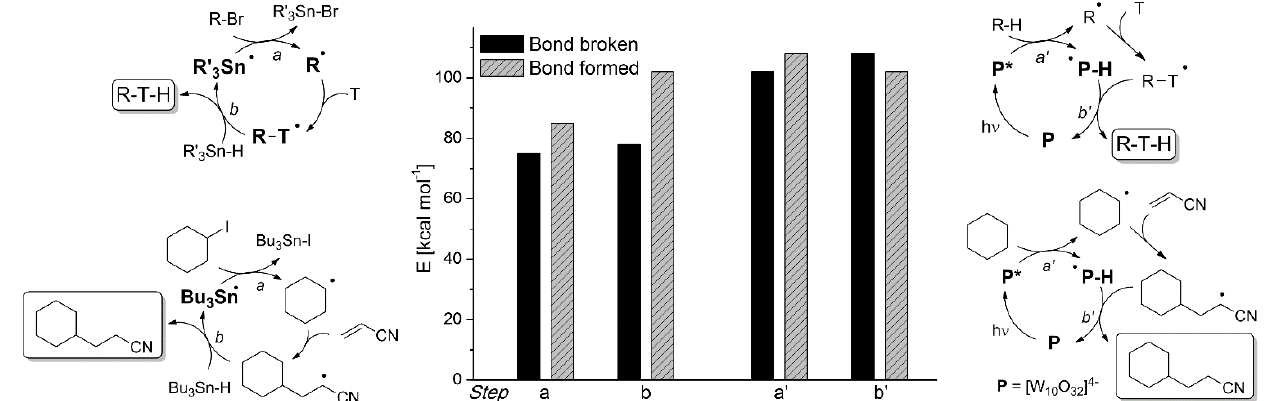
Figure 2. Chain vs. non-chain, photocatalytic process. The energy change associated to each step is considered. In the thermal chain process [50], both steps a and b involve the formation of a bond that is more energetic than the one that is cleaved, and the overall process involves relatively low energies. On the contrary, steps a' and b' in the photocatalytic process [15] involve the cleavage of a strong bond and the endergonic nature of the latter step precludes a chain process. Adapted from Ref.